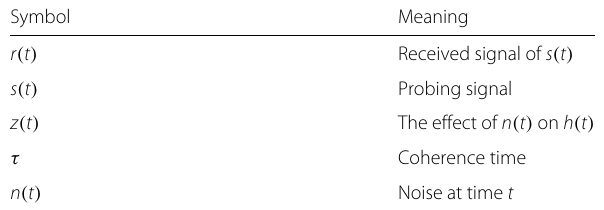
Table 1 A summary of the symbol